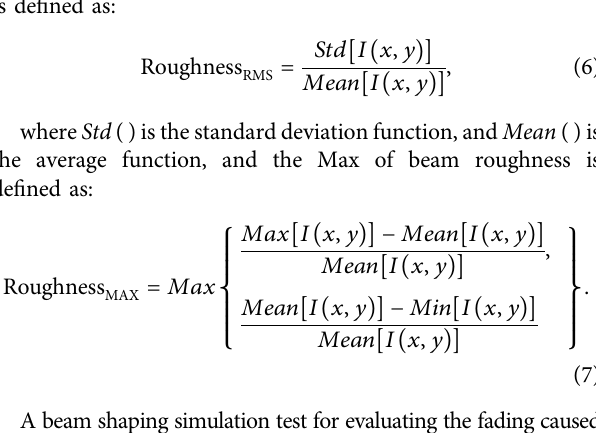
Frontiers in Physics |